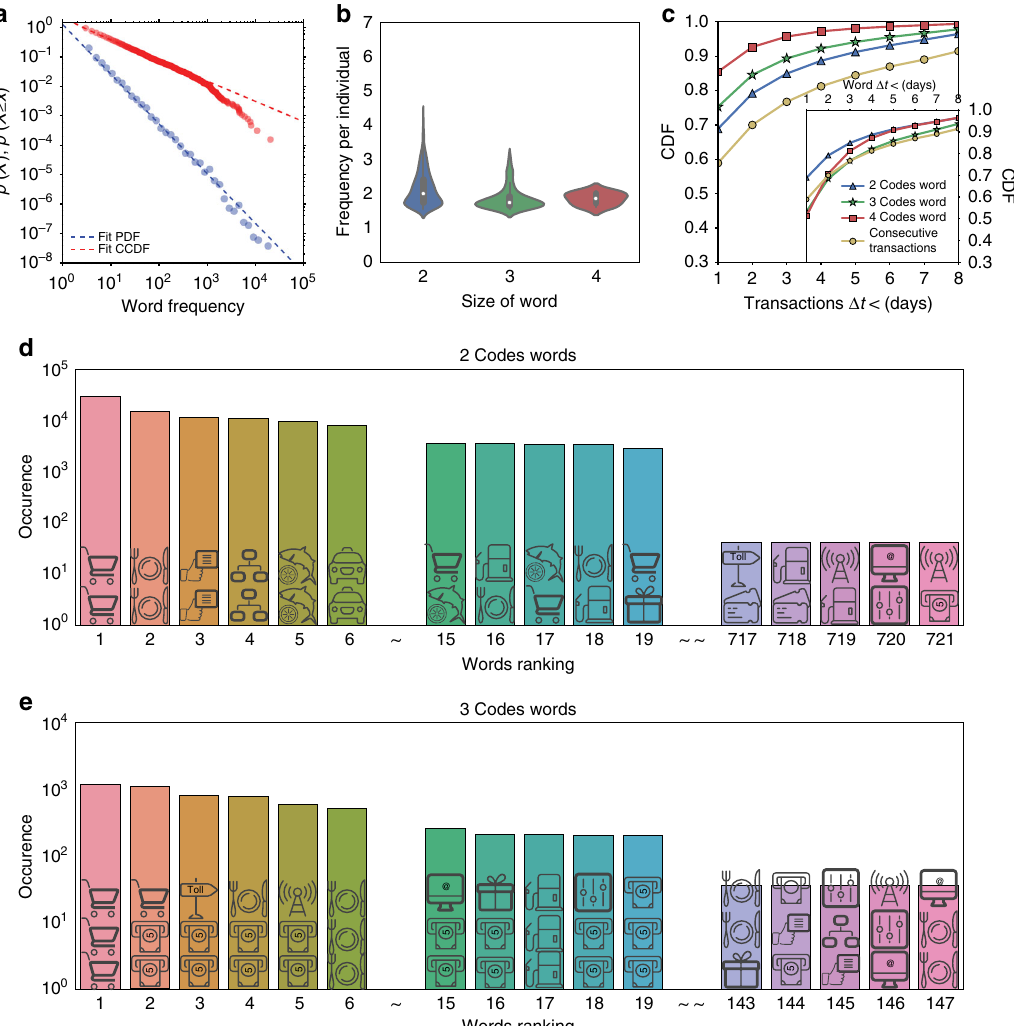
Fig. 3 Semantic analysis of transaction sequences. a Probability density function plot of the occurrence of words { w i } and its complementary cumulative distribution; the probability distribution words manifest a power-law behavior p ð w i Þ / x ð(cid:2) 1 : 70 Þ i , with x i frequency of the { w i } and Kolmogorov – Smirnov distance D n = 0.014. b Distribution of the occurrence of words in the transaction sequences by the word length. c Inter-time transactions between purchases. The purchases within each word are more likely to occur within a day with respect to two random consecutive transactions. c (inside) Moreover, the purchase time to accomplish a word completely is less with respect to two random consecutive transactions. d , e Examples of words composed by two and three codes, respectively, ordered by the number of occurrences. The icons used in this fi gure are work of